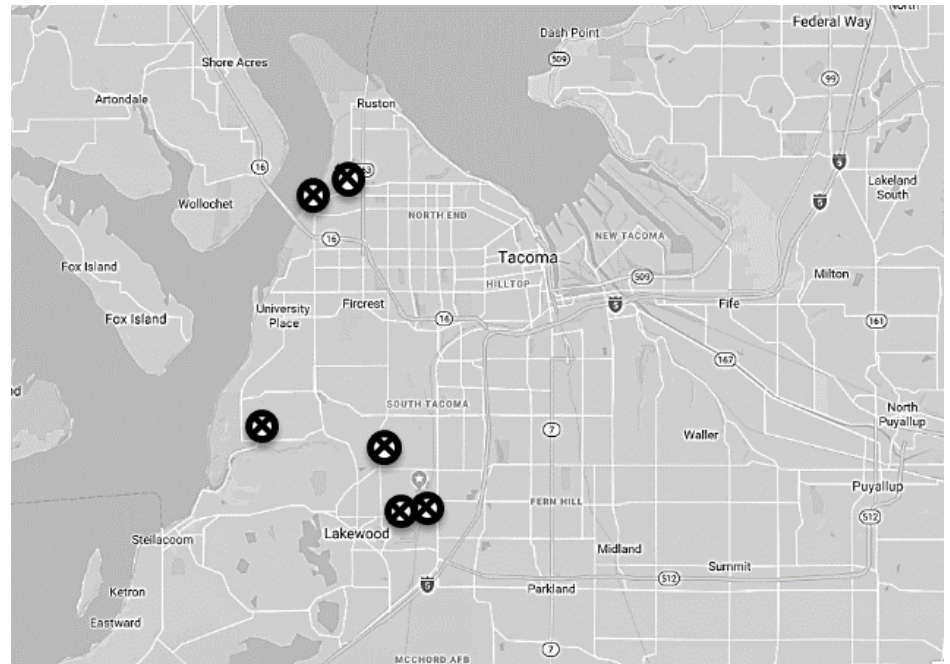
Figure 1. Six sites (two pure hemlock stands, two stands containing conifers other than hemlock, and two mixed stands of western hemlock and native conifers) were sampled in Tacoma, WA twice monthly for one full year (October 2015–November 2016) to determine seasonal abundance of S. coniferarum and adelgid species present.